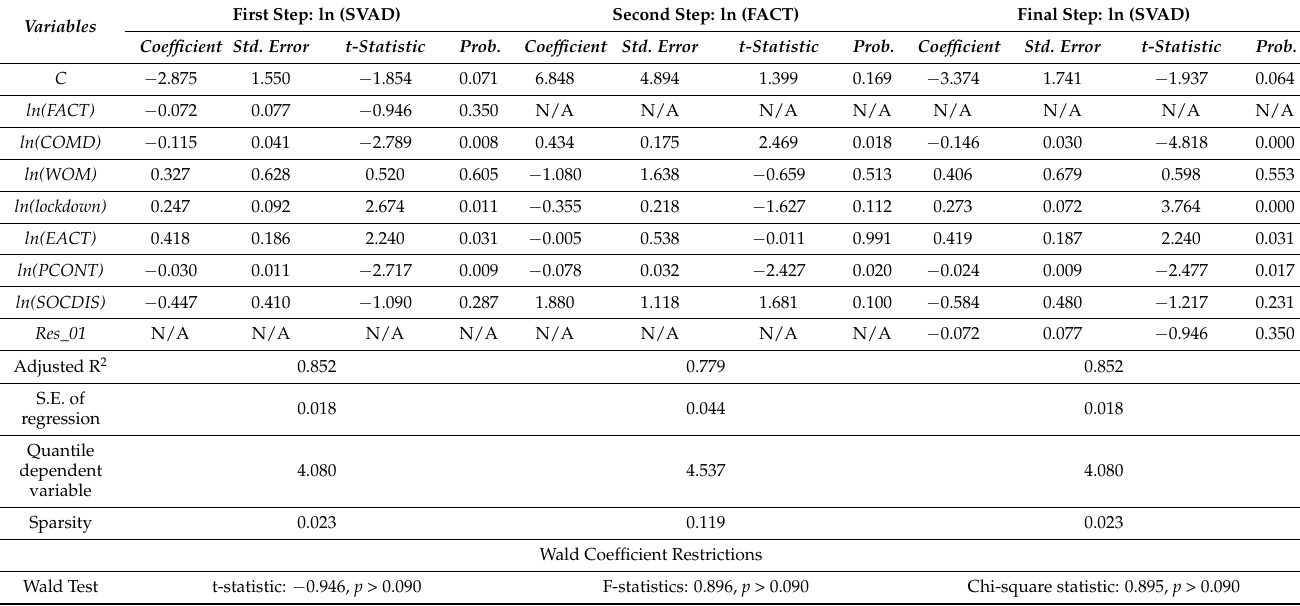
Table 6. Endogeneity Test performed by Quantiles Median